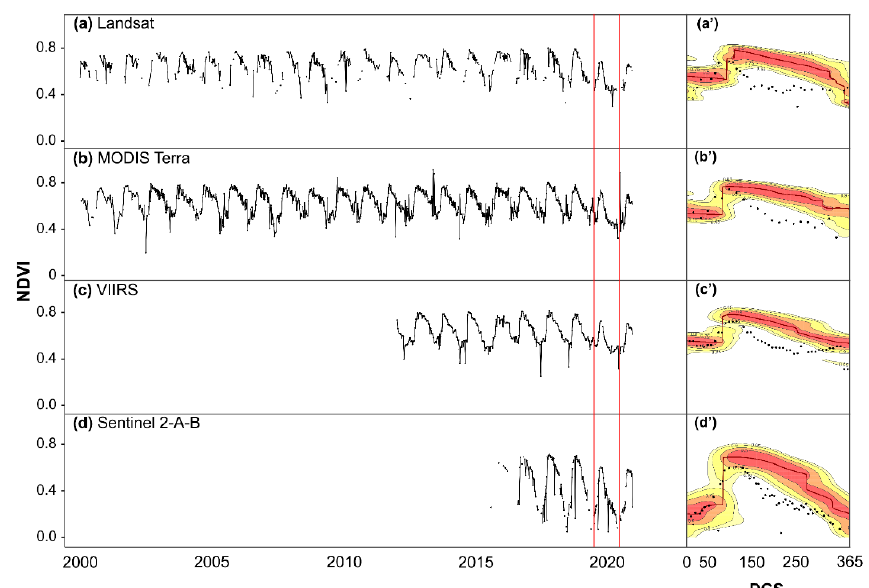
Figure 7. NDVI time series of a single pixel of deciduous Nothofagus macrocarpa native forest in Central Chile (71°W, 33°S) from four different remote sensing products ( a – d ). Since all datasets have different time frames, for comparison purposes, we set as a reference period all dates except for the GS 2019 – 2020 (between the red lines) when the extreme drought described in Section 3.1 took place. In all cases, the reference phenology and its variability could be described by the KDE estimations ( a’ – d’ ) and extreme negative detected in